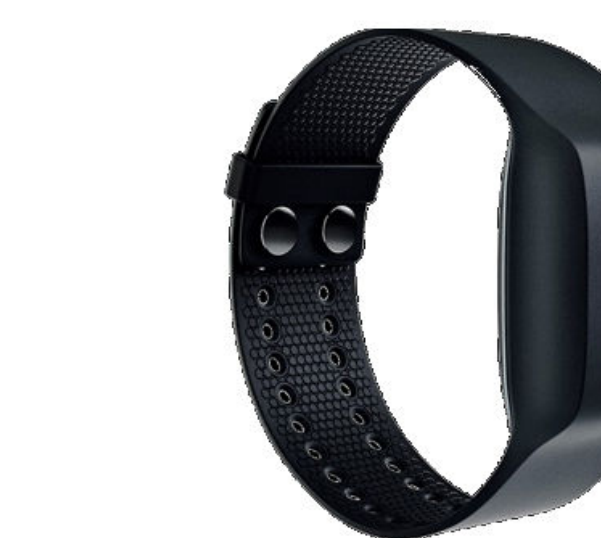
Figure 2. Empatica E4